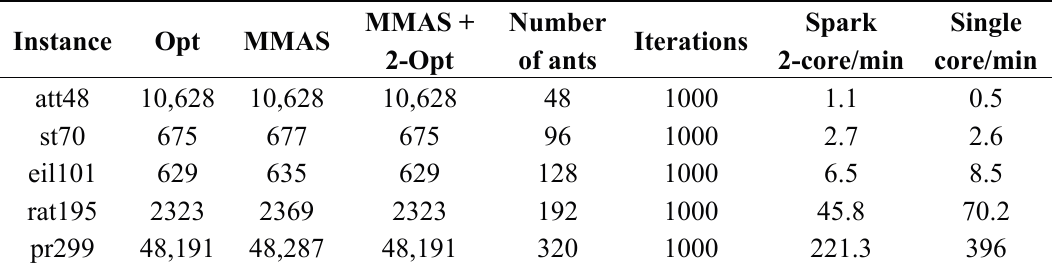
Table 1. Comparison between single core program and Spark